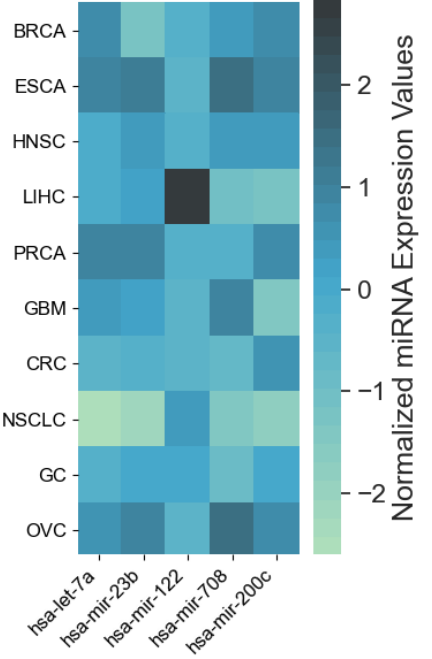
Figure 3. Heatmap of average expression levels by cancer type for the 5 miRNAs identified by the proposed approach. Cancer types: breat (BRCA); esophageal (ESCA); head and neck squamous